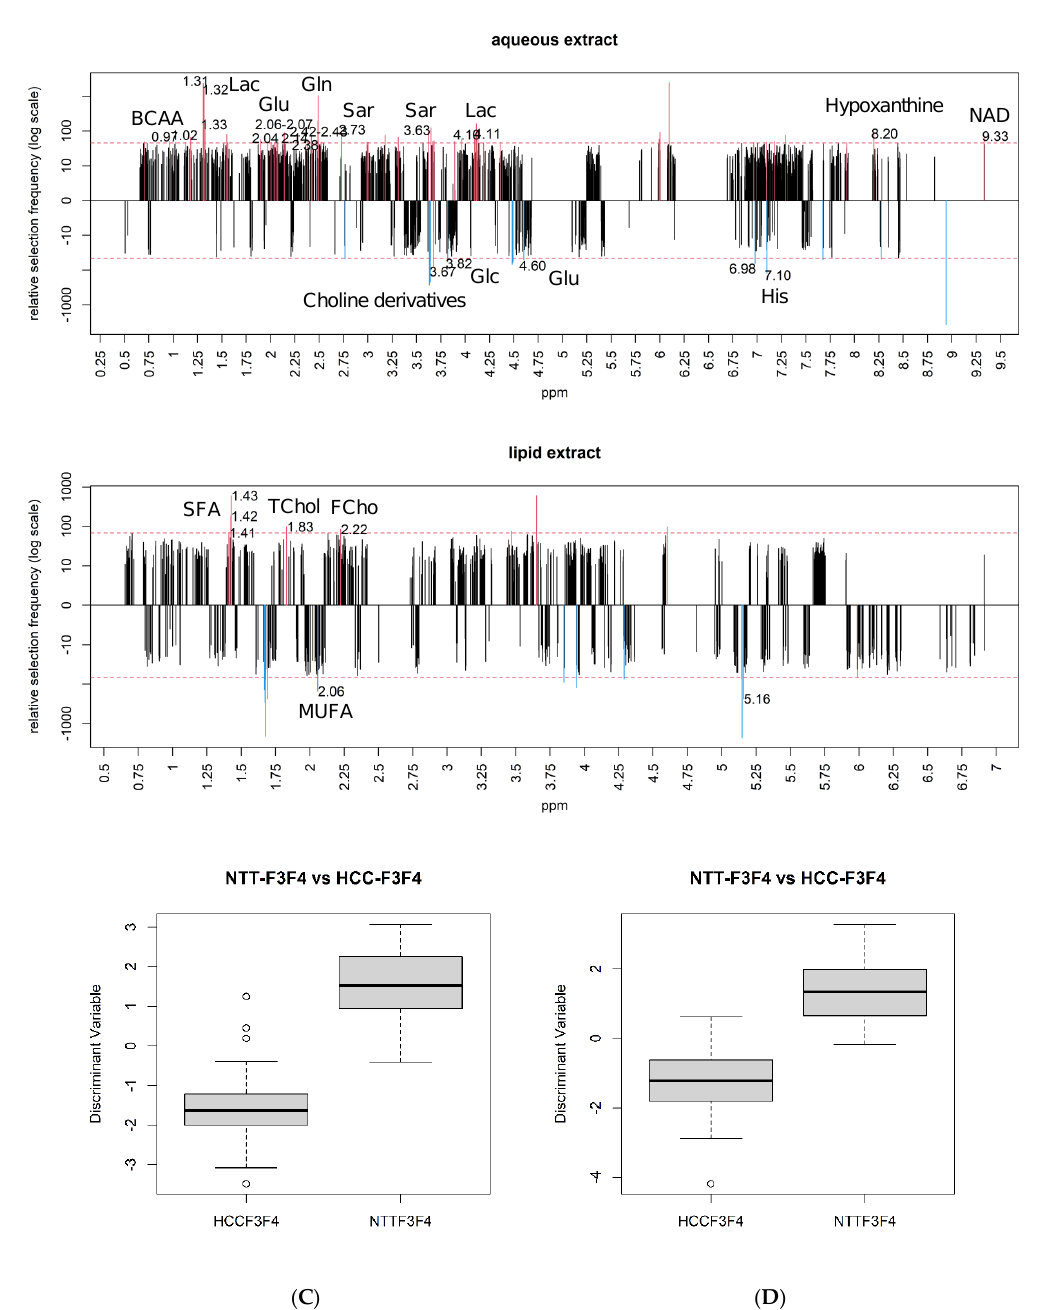
Figure 2. Frequency of selection of each ppm location in the aqueous ( A ) and lipid phases ( B ) from the comparison between HCC-F3F4 and NTT-F3F4. Discriminant metabolites (above the number of selection threshold in dotted line) are illustrated in red for upregulated and blue for downregulated metabolites in HCC. In the aqueous phase ( A ), Branched Chain Amino Acids (BCAA) (ppm 0.97/1.02), lactate (ppm 1.31–1.33/4.10–4.11), glutamine (ppm 2.14/2.42–2.43), glutamate (ppm 2.06–2.07/2.38), sarcosine (ppm 2.73/3.63), hypoxanthine (ppm 8.20), Nicotinamide Adenine Dinucleotide (NAD) (ppm 9.33), glucose (ppm 3.82/4.60), choline derivatives (ppm 3.67), and histidine (ppm 6.98/7.10) were identified as discriminant metabolites. In the lipid phase ( B ), saturated fatty acids (ppm 1.41–1.43), total cholesterol (ppm 1.83), free cholesterol (ppm 2.22), and monounsaturated fatty acids (ppm 2.06) were identified as discriminant metabolites. Subsets of metabolites in the aqueous ( C ) and lipid phases ( D ) demonstrated significant accuracy to differentiate HCC from NTT in F0F1